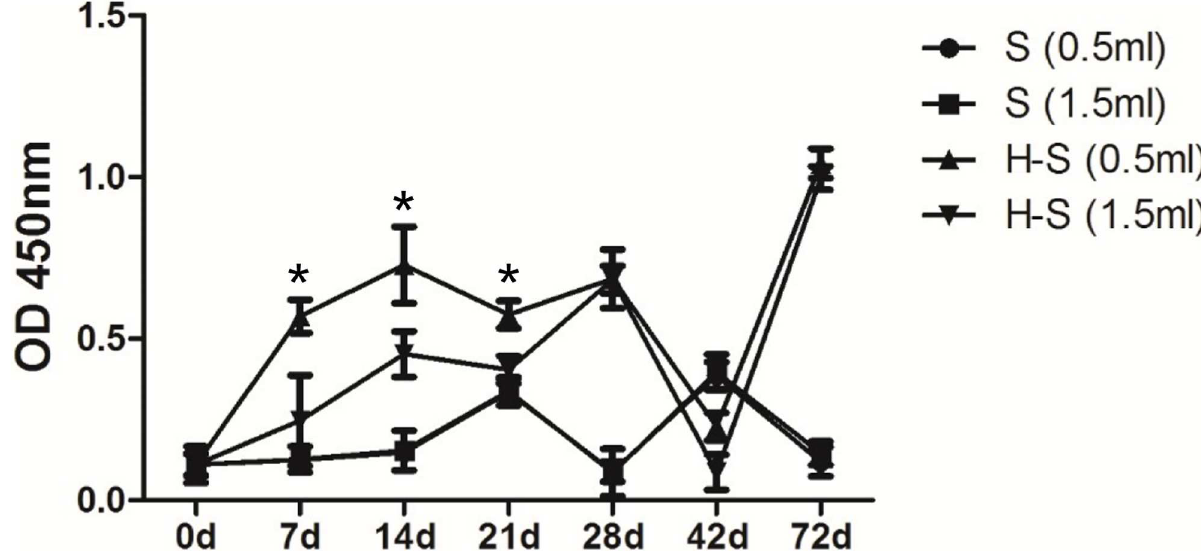
Fig 4. SBP-specific antibody production in rats. Rats (n = 10) were immunizedintramuscularly 3 times at a 2-week interval with vaccine alone (H) or together with SBP (H-S). Blood samples were collectedon indicatedtime points and anti-SBP total IgG was measuredby ELISA. Results are expressedas the means ± SEM. * p <